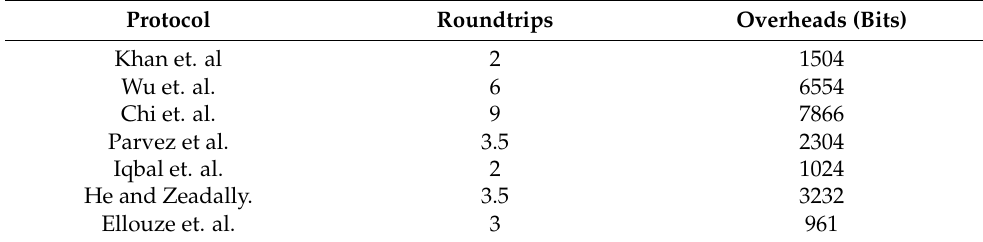
Table 8. Communication overheads of the authentication